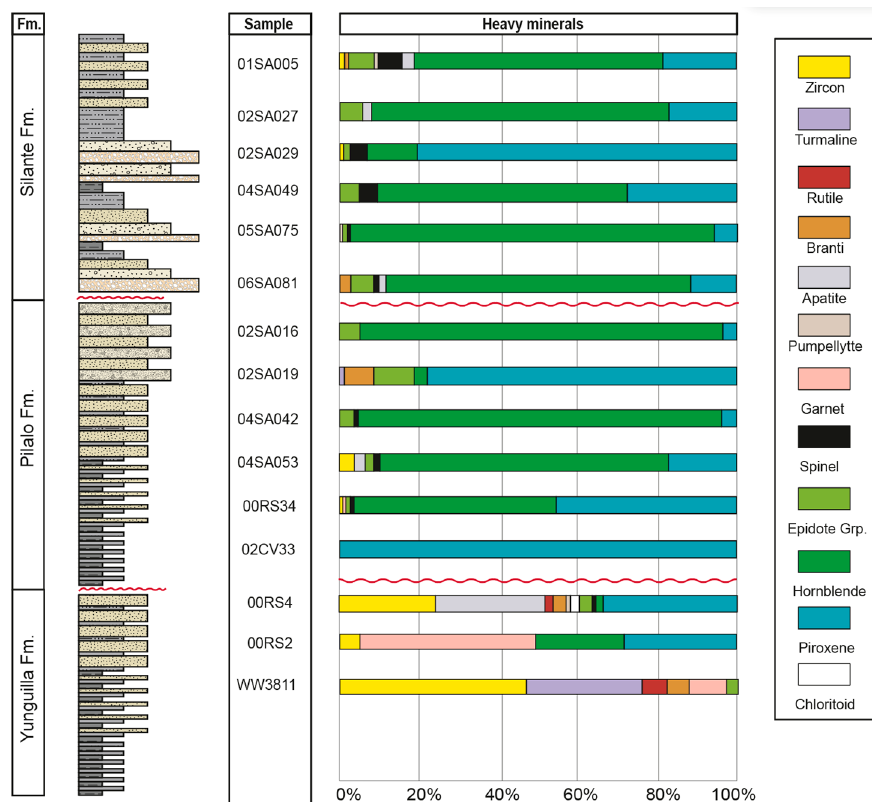
Figure 9. Composite stratigraphic column of the Yunguilla, Pilalo and Silante formations and heavy mineral frequencies (right). A clear change is observed in the composition of the Pilalo and Silante formations, which were derived from volcanic sources, whereas Campanian–Maastrichtian sediments of the Yunguilla Formation were shed from granitic and metamorphic sources that formed part of a continental plate, and now constitute the Eastern Cordillera.